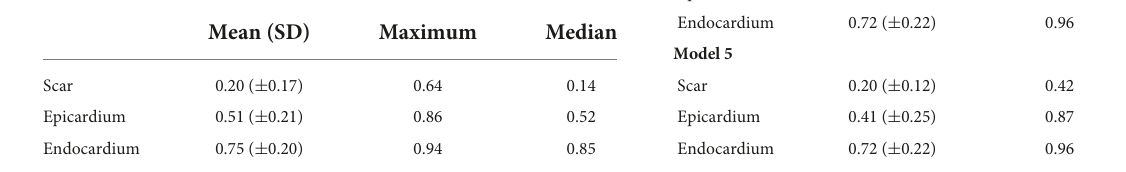
TABLE 1 The mean, maximum and median Dice scores of the UNet segmentation